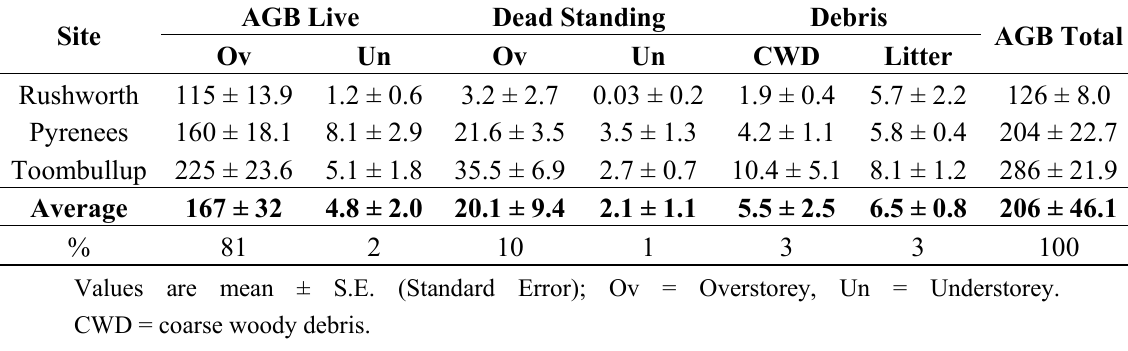
Table 2. Aboveground biomass (AGB, t·dm·ha −1 ) in medium open Eucalyptus forests of south-eastern Australia. AGB Live Dead Standing Debris Site Ov Un Ov Un CWD Litter Rushworth 115 ± 13.9 1.2 ± 0.6 3.2 ± 2.7 0.03 ± 0.2 1.9 ± 0.4 5.7 ± 2.2 126 ± 8.0 Pyrenees 160 ± 18.1 Toombullup 225 ± 23.6 Average % 81 3 3 100 Values are mean ± S.E. (Standard Error); Ov = Overstorey, Un = Understorey. CWD = coarse woody debris.